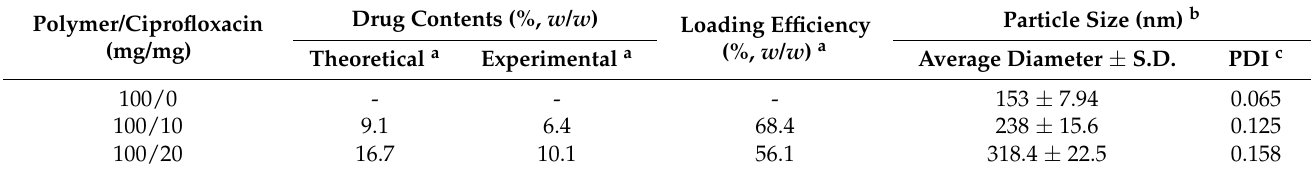
Table 1. Drug contents and particle size of ciprofloxacin-incorporated